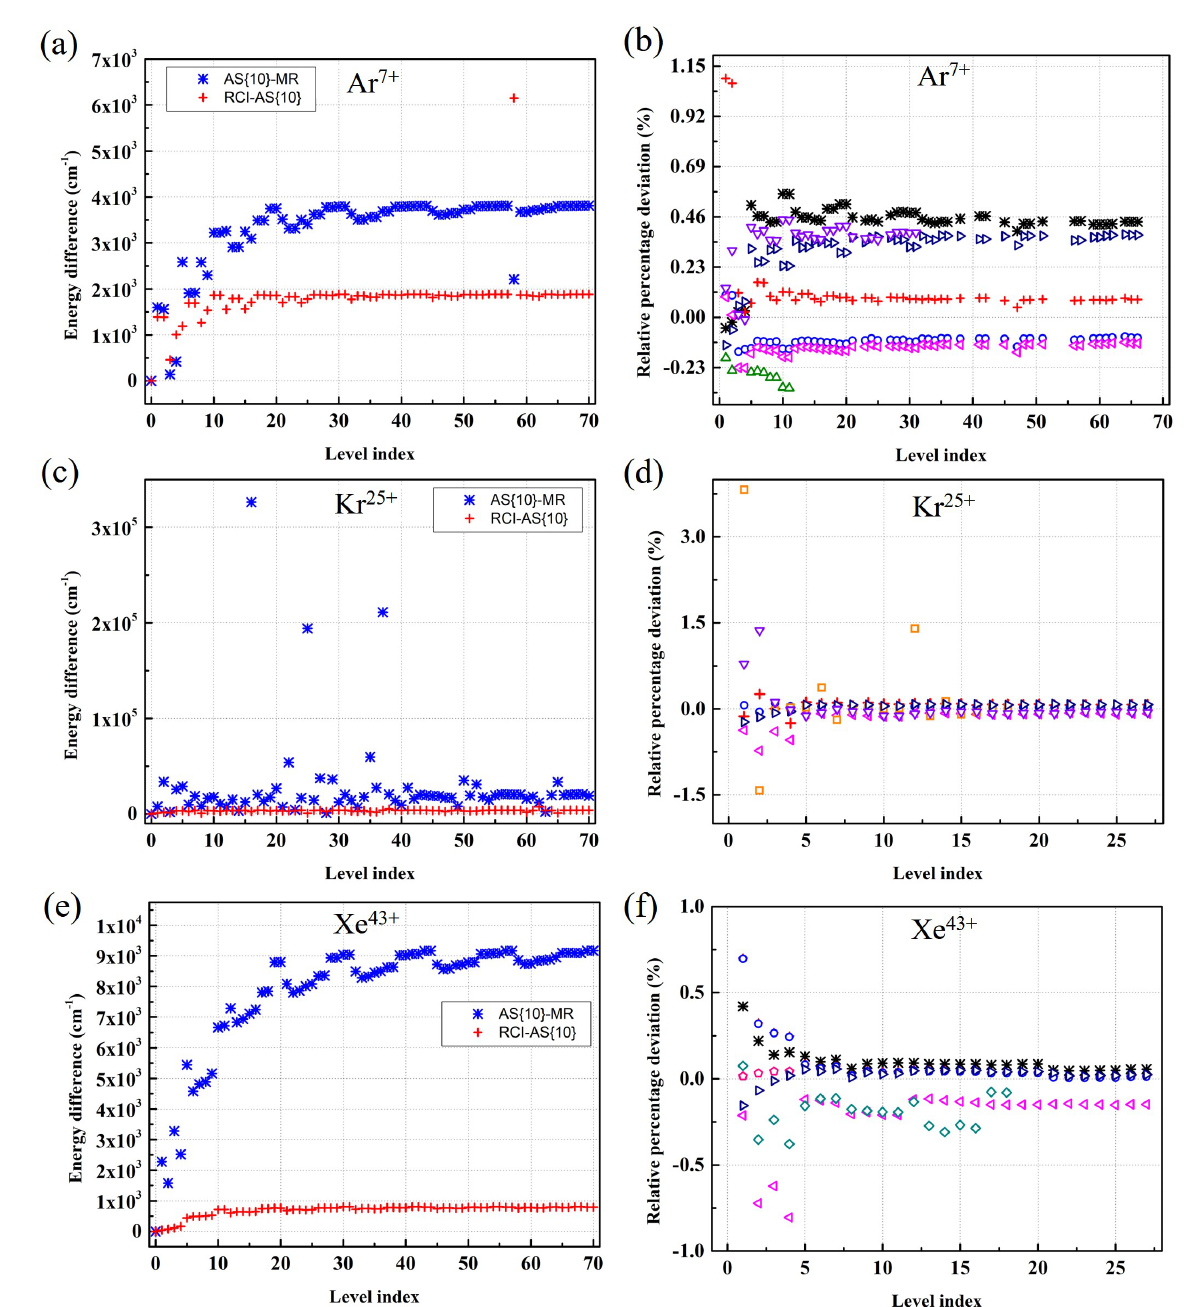
Figure 1. ( a , c , e ): The energy difference AS{10} − MR and RCI − AS{10}; ( b , d , f ): The relative percentage deviation of the present MR (star), AS{10} (plus), RCI (circle), RSCF (leftward triangle), MBPT (rightward triangle) and previous work of Froese Fischer et al. [20] (upward triangle); Liang et al. [22] (downward triangle); Younis et al. [19] (square); Vilkas et al. [21] (pentagon); and Ivanov and Ivanova [15] (diamond) with respect to the NIST ASD